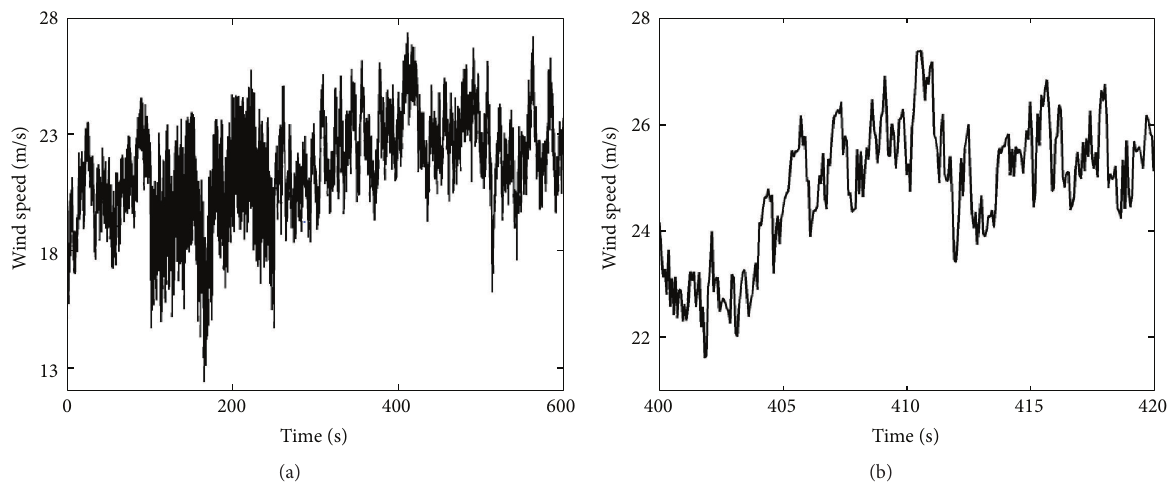
Figure 5: Typical realization of a wind time series at a 10Hz sampling rate: (a) 10-minute duration and (b) zoom on 20 seconds.